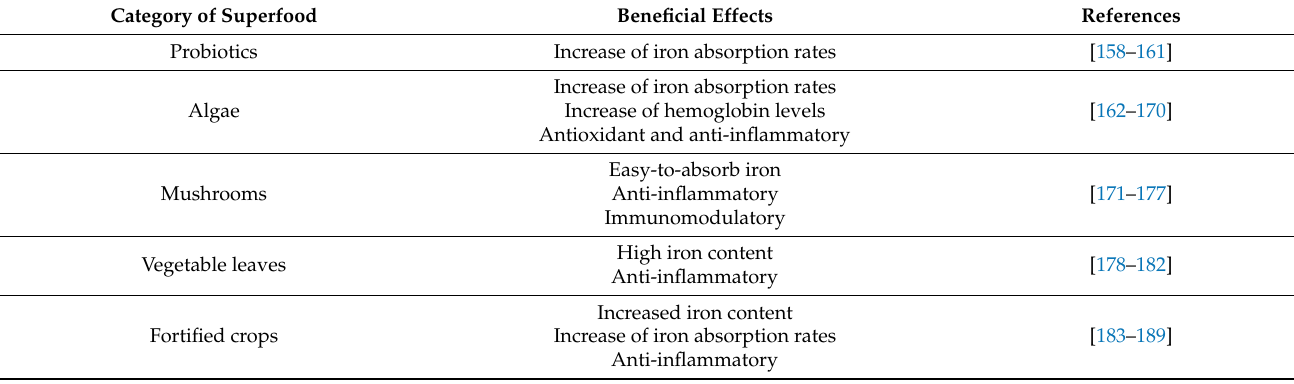
Table 1. Categories of superfoods with high iron content and their effects on health. Category of